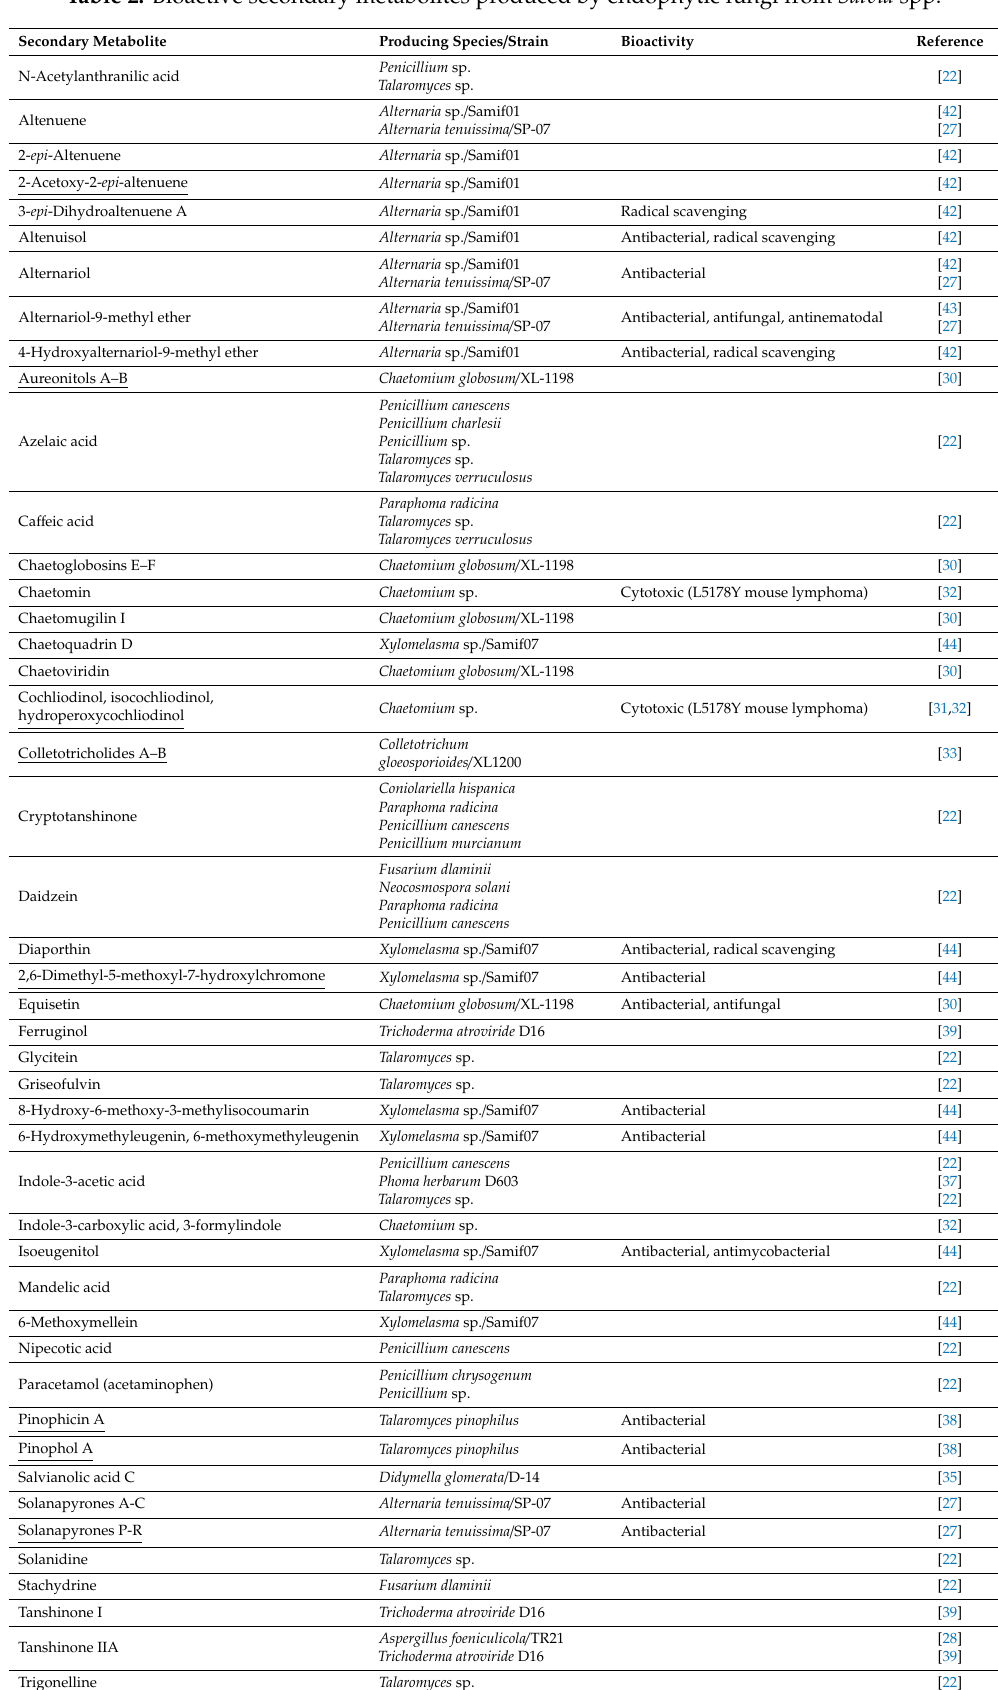
Table 2. Bioactive secondary metabolites produced by endophytic fungi from Salvia